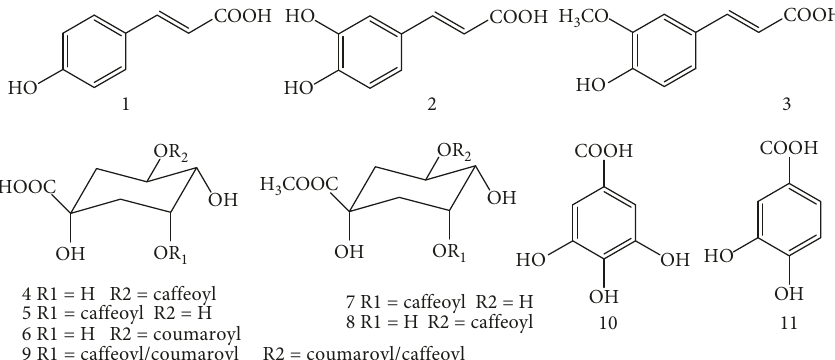
Figure 1: The chemical structures of the compounds 1 – 11 isolated from P. cerasifera Ldb leaves.